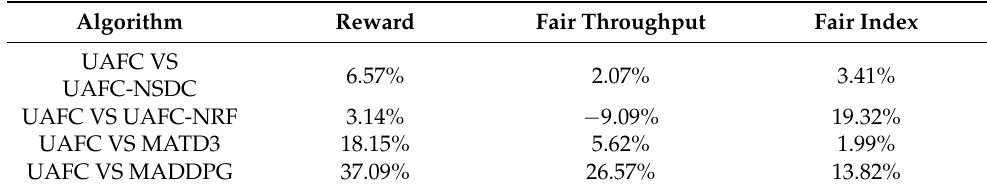
Table 4. Comparison of results on reward function, fair throughput, and fair index.